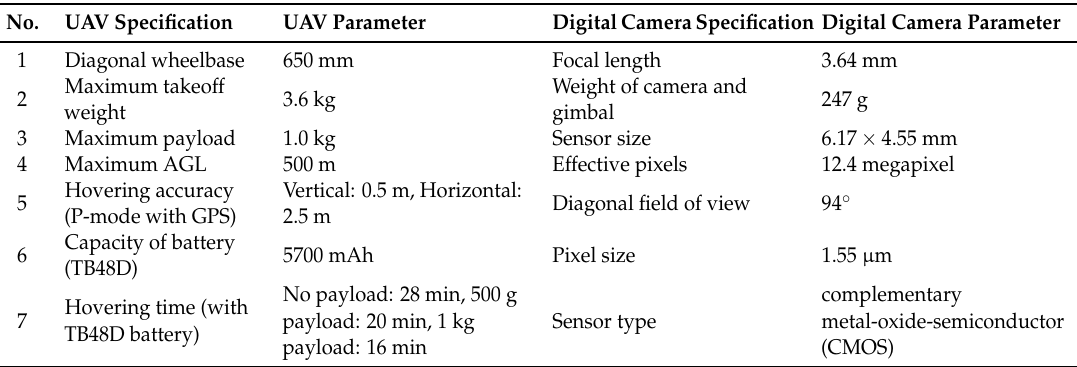
Table 1. Specifications of sUAS employed in this